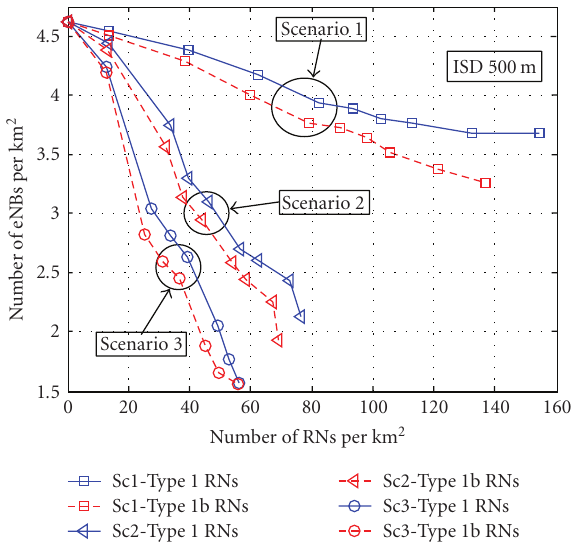
Figure 3: ISO-performance curve - ISD 500m.